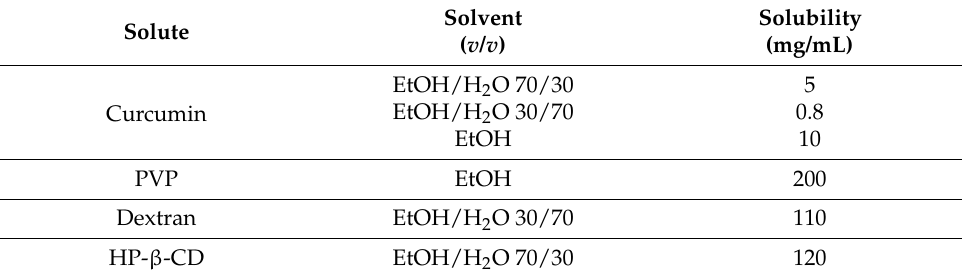
Table 1. Solubility of CUR, PVP, DEX, and HP- β -CD in ethanol/water mixtures. Solute